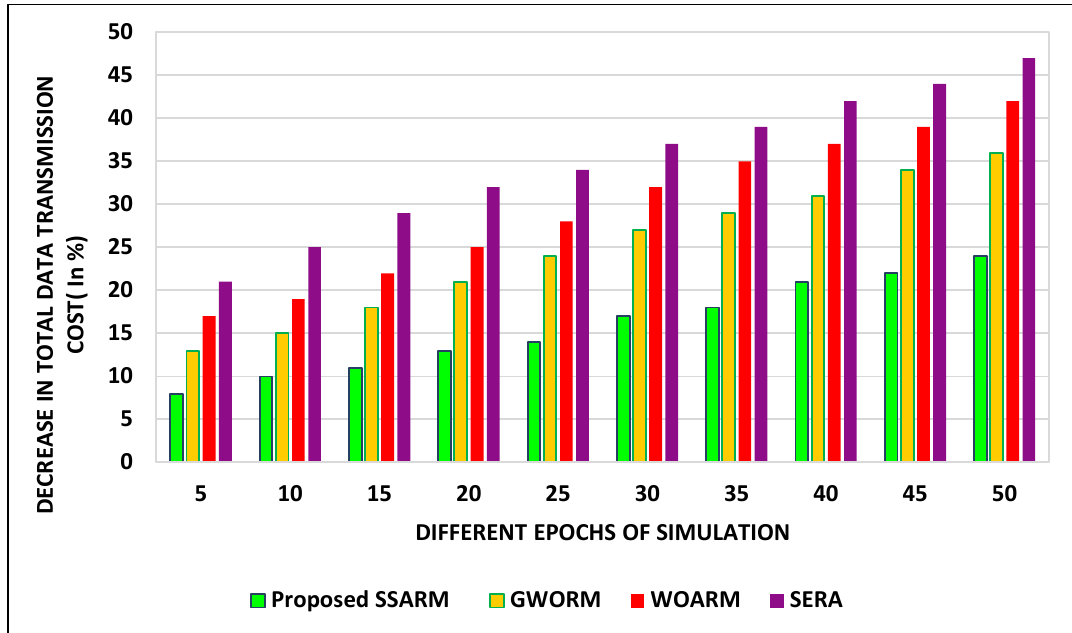
Figure 5. Proposed SSARM-Optimality in Resource Assignment with Different Epochs of Simulation